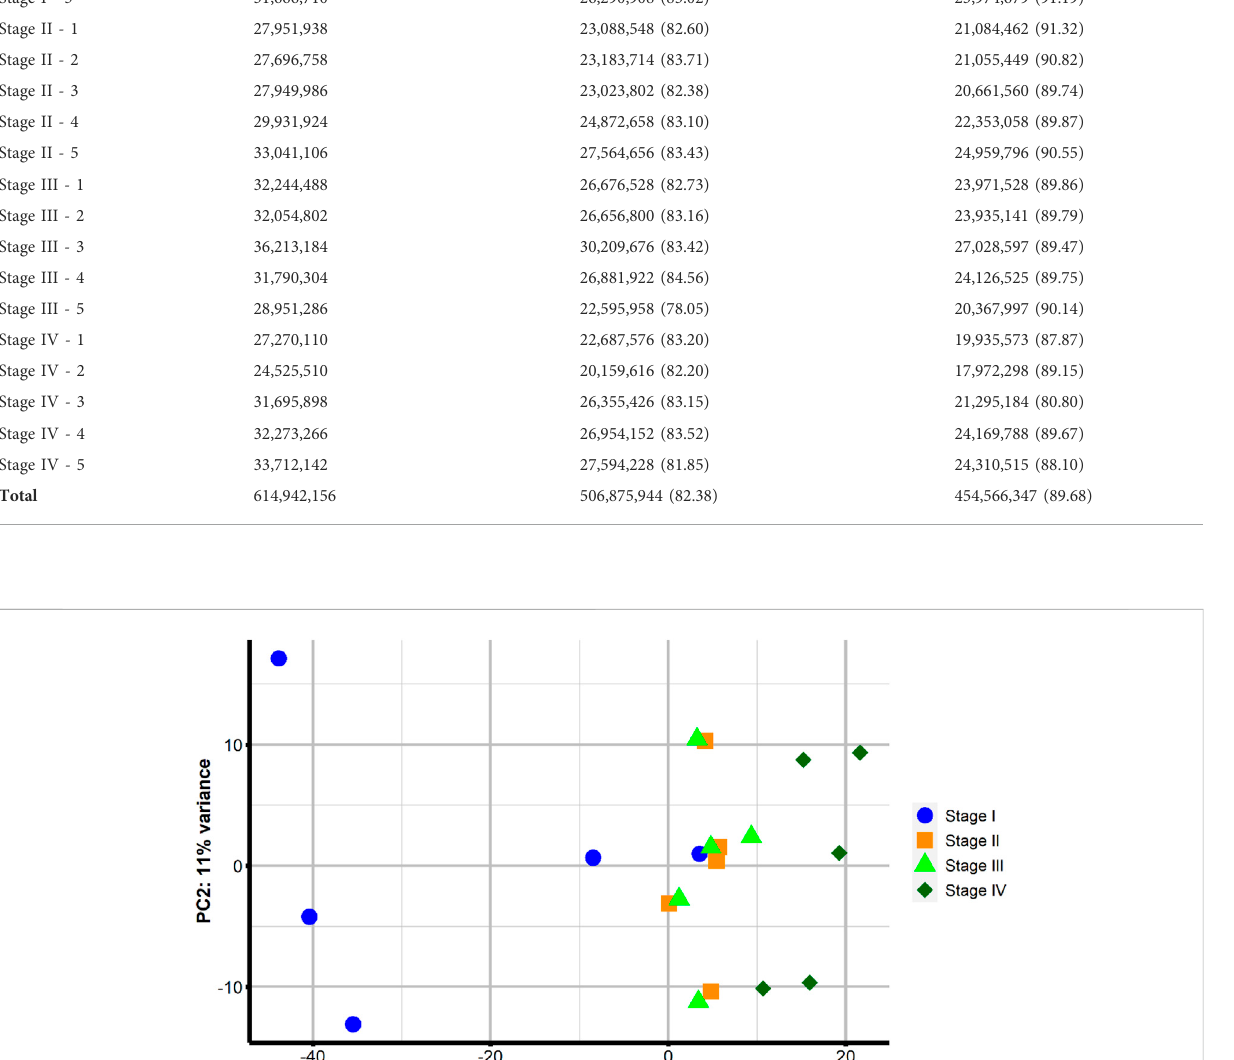
the transition from Stage III to full-grown oocytes (Stage IV) after rLh application. The corresponding numbers for downregulated genes were 2,807, 299, and 593, respectively.